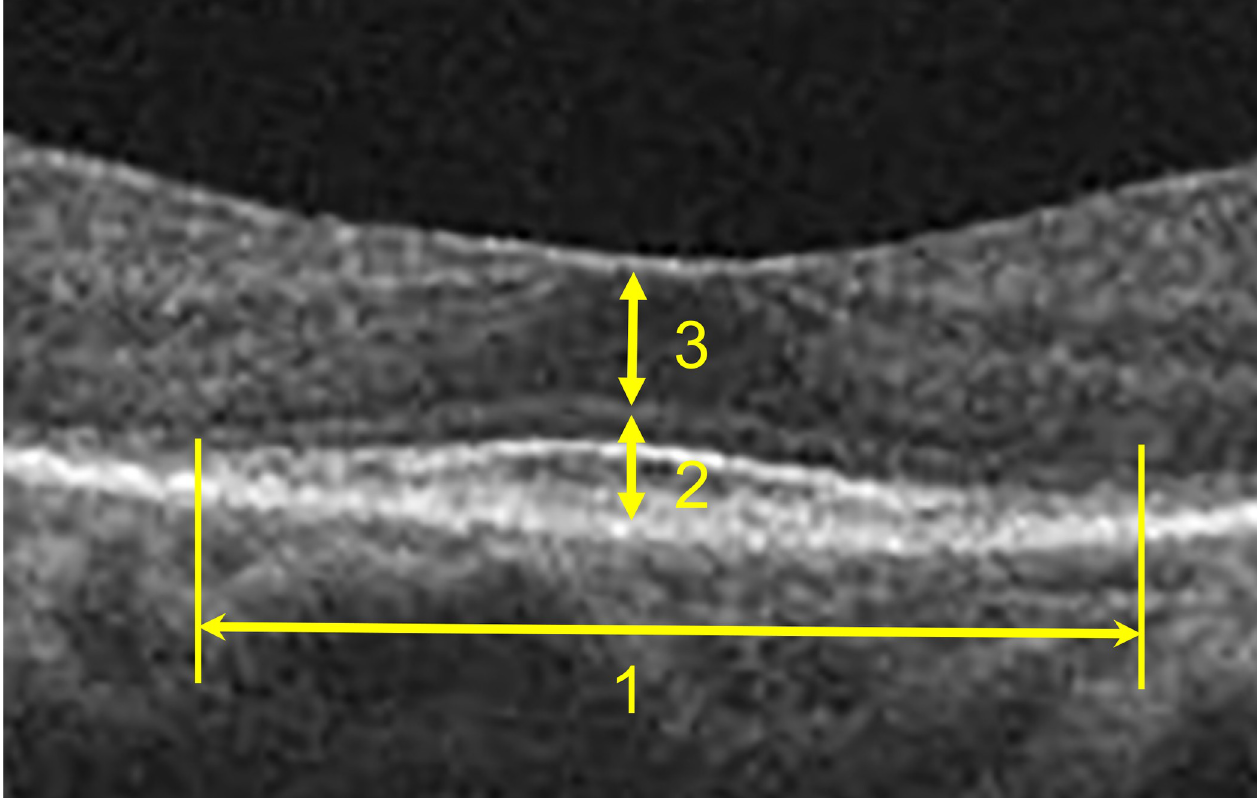
Fig 3. Diagrams of quantitative SD-OCT parameters. 1, width of inner segment ellipsoid zone (IS-EZ); 2, thickness of photoreceptor inner and outer segments (IS/OS) layer; 3, thickness of the outer nuclear layer (ONL).